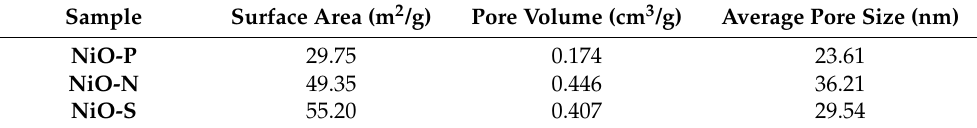
Table 4. The Surface area, pore volume and average pore size of NiO-P, NiO-N, and NiO-S. Sample